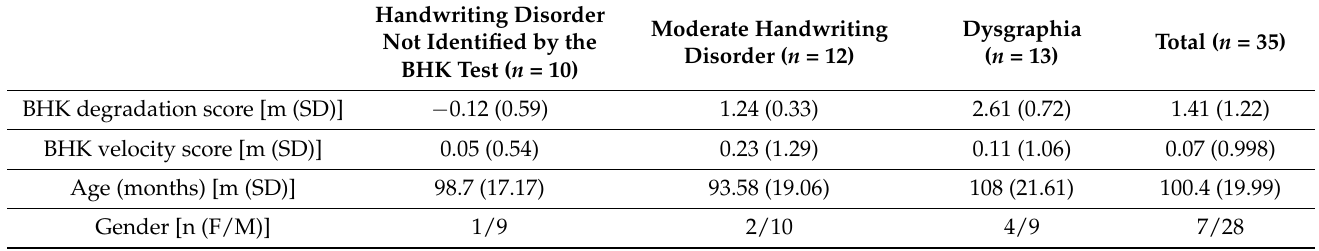
Table 1. Characteristic of the